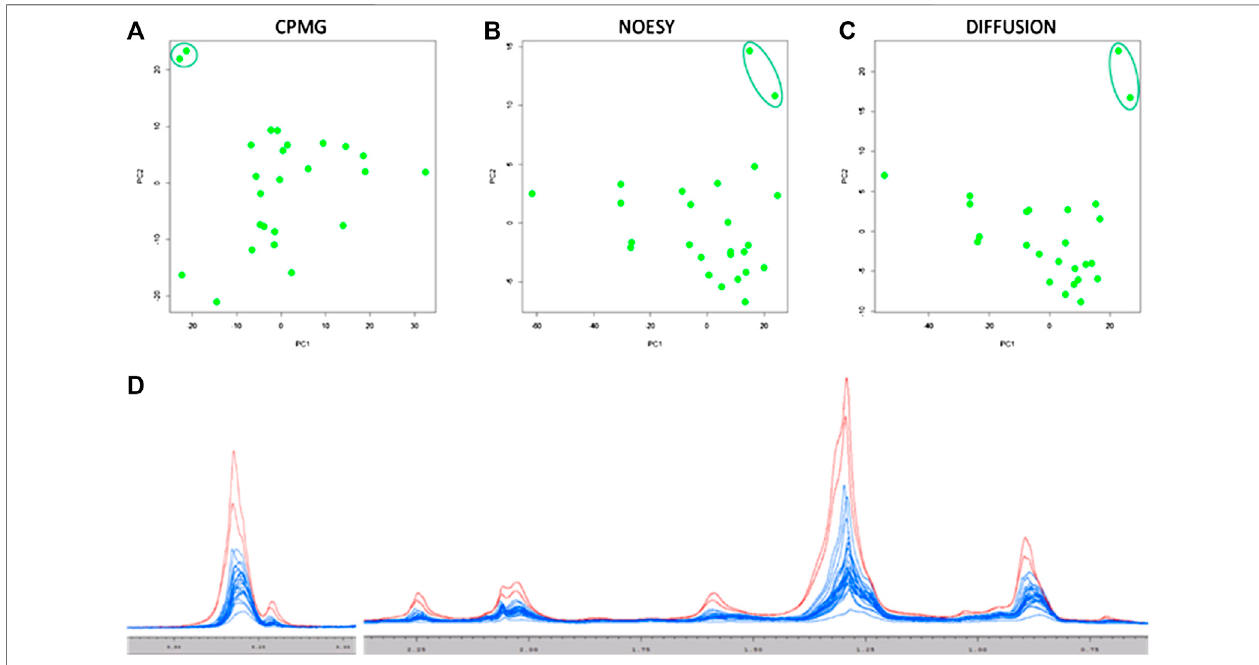
FIGURE1| Scoreplots ofthe fi rst twoprincipalcomponentsofthePCA analysison the three serum NMR spectra acquired: (A) CPMG; (B) NOESY; (C) Diffusion. All Diffusion spectra are reported in panel (D) , the two outlier samples are colored in red (one responder patient and one non-responder patient).